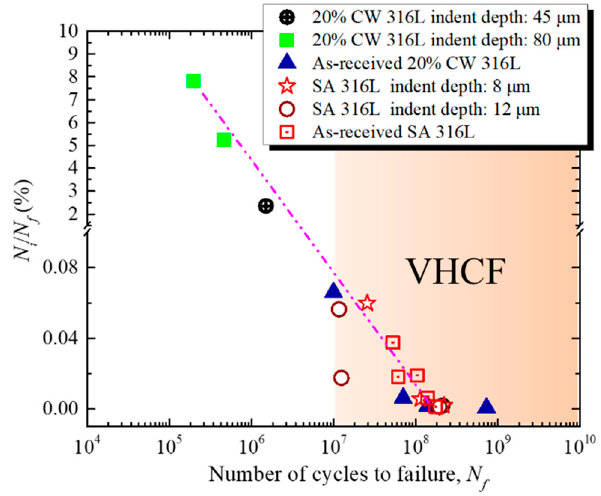
Figure 9. Dependence of the crack propagation life ( N i ) over the fatigue life ( N f ) on the number of cycles to failure of SA and 20% CW 316L.